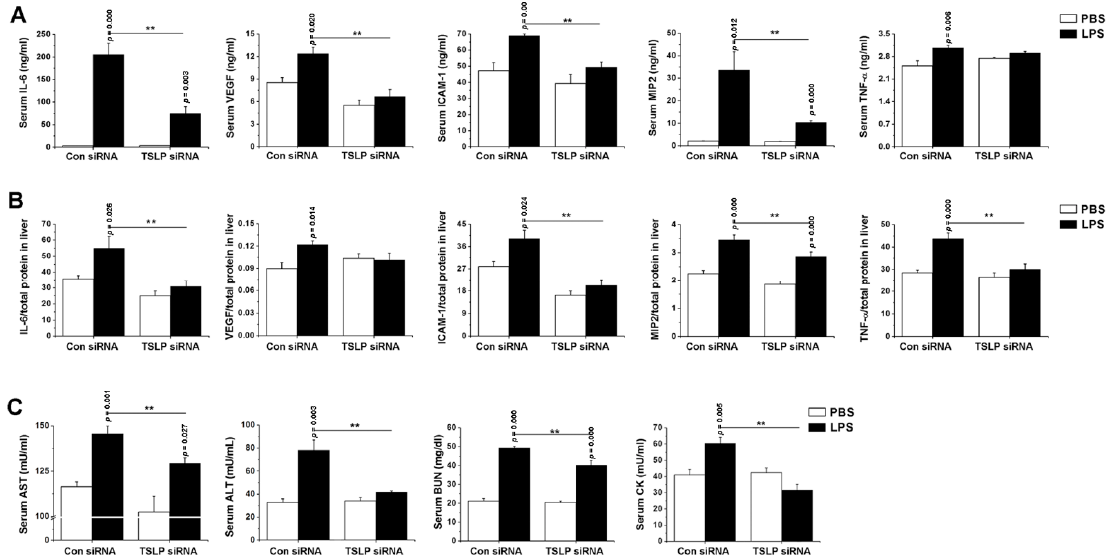
Figure 2. Systemic inflammatory reaction is blunted by the deficiency of TSLP during sepsis. Mice were given either scramble control or TSLP-specific siRNA + atelocollagen mixture. Each level in ( A ) serum at 4 h and ( B ) liver homogenate at 12 h following LPS (10 mg / kg) injection was analyzed by ELISA. Adducts were normalized to total protein in liver homogenate. ( C ) Each level was analyzed in serum ( n = 10 / group). A p value indicates the significant di ff erence between PBS and LPS. ** p < 0.05 vs. Con siRNA-received and LPS-injected control mice. PBS, phosphate-bu ff ered saline; LPS, lipopolysaccharide; TSLP, thymic stromal lymphopoietin; Con, control; siRNA, small interfering RNA; VEGF, vascular endothelial growth factor; ICAM-1, intercellular adhesion molecule-1; MIP2, macrophage inflammatory protein 2; AST, aspartate aminotransferase; ALT, alanine aminotransferase, BUN, blood urea nitrogen; CK, creatine kinase.